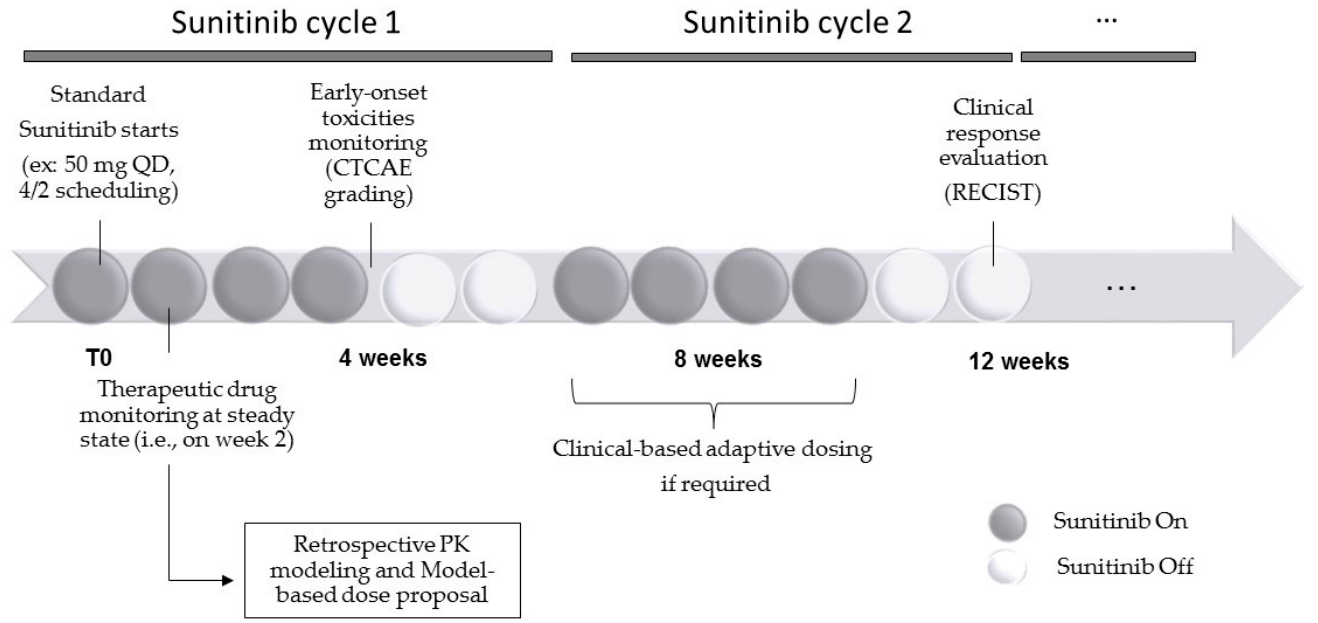
Figure 7. Generic time line of the study.